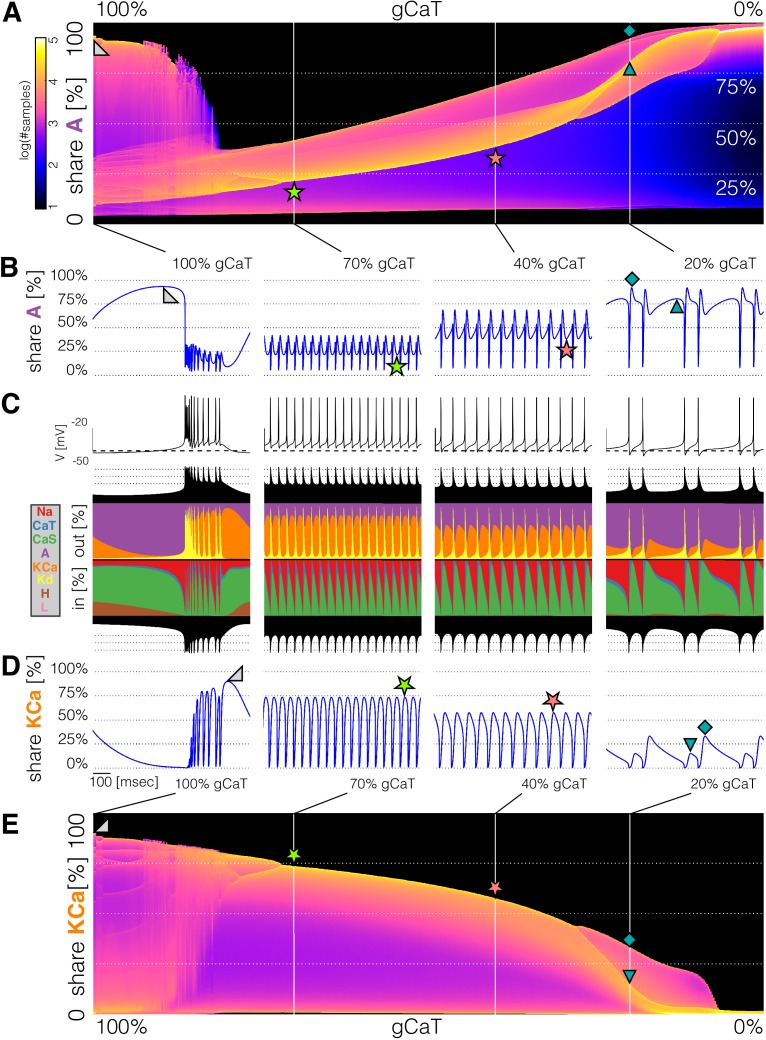
Probability distributions of currents shares.The Figure shows the relationship between the currentscapes and the distributions of current shares. (A) Distribution of A current share to the total outward current for 1001 values of gCaT between 0% and 100%. (B) Share of A current as a time series. The A current contributes with more than 50% of the outward current for most of the time. At 70%gCaT the cell spikes tonically and the A contributes 50% of the outward current most of the time. The symbols indicate features in the waveform that are mapped to ridges in the distribution. (C) Currentscapes. (D) Idem (B) but for KCa. Notice the share of KCa decreasing as gCaT→0. (E) Distribution of KCa current share to the total outward current for 1001 values of gCaT between 0% and 100%.